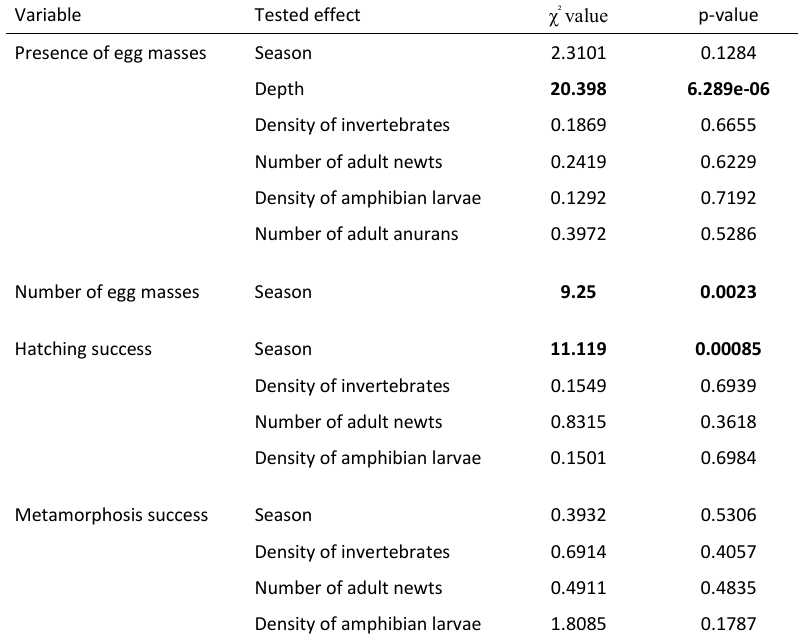
Table 2: Results of the statistical analyses performed to explain the variation of presence of egg masses , number of egg masses , hatching success and metamorphosis success . Bold letters indicate a significant test (p-value <